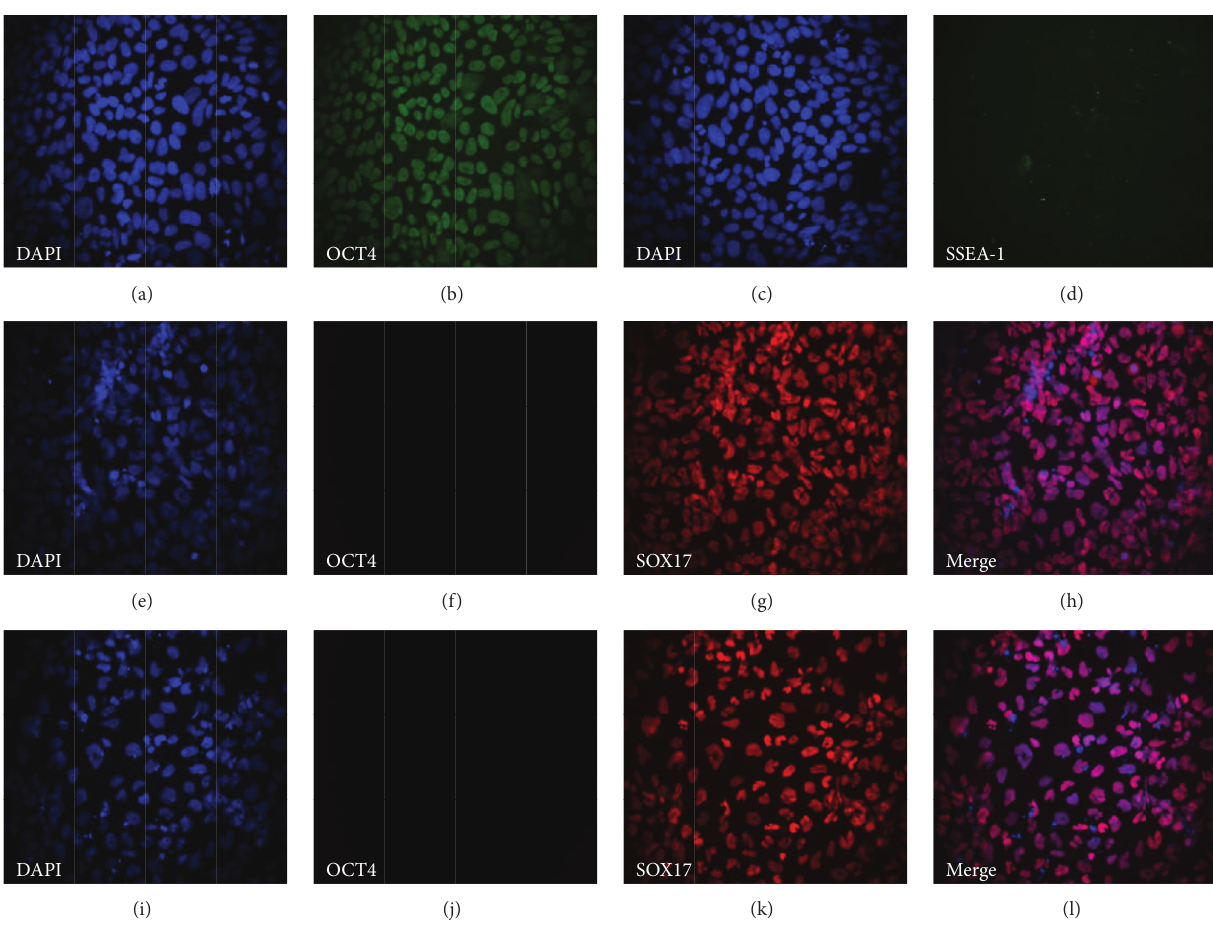
Figure 8: Representative micrographs from immunocytochemical analysis at days 0, 5, and 7 during hepatic differentiation of the cell line AS034. Magnification: 20x. Panels (a)–(d) show staining of undifferentiated hPSC at day 0: (a) and (c) show nuclear DAPI staining, (b) shows Oct4 staining, and (d) shows SSEA-1 staining. Panels (e)–(h) show staining of DE cells at day 5 of differentiation: (e) shows nuclear DAPI staining, (f) shows Oct4 staining, (g) shows Sox17 staining, and (h) shows a merge of DAPI and Sox17 staining. Panels (i)–(l) show staining of DE cells at day 7 of differentiation: (i) shows nuclear DAPI staining, (j) shows Oct4 staining, (k) shows Sox17 staining, and (l) shows a merge of DAPI and Sox17